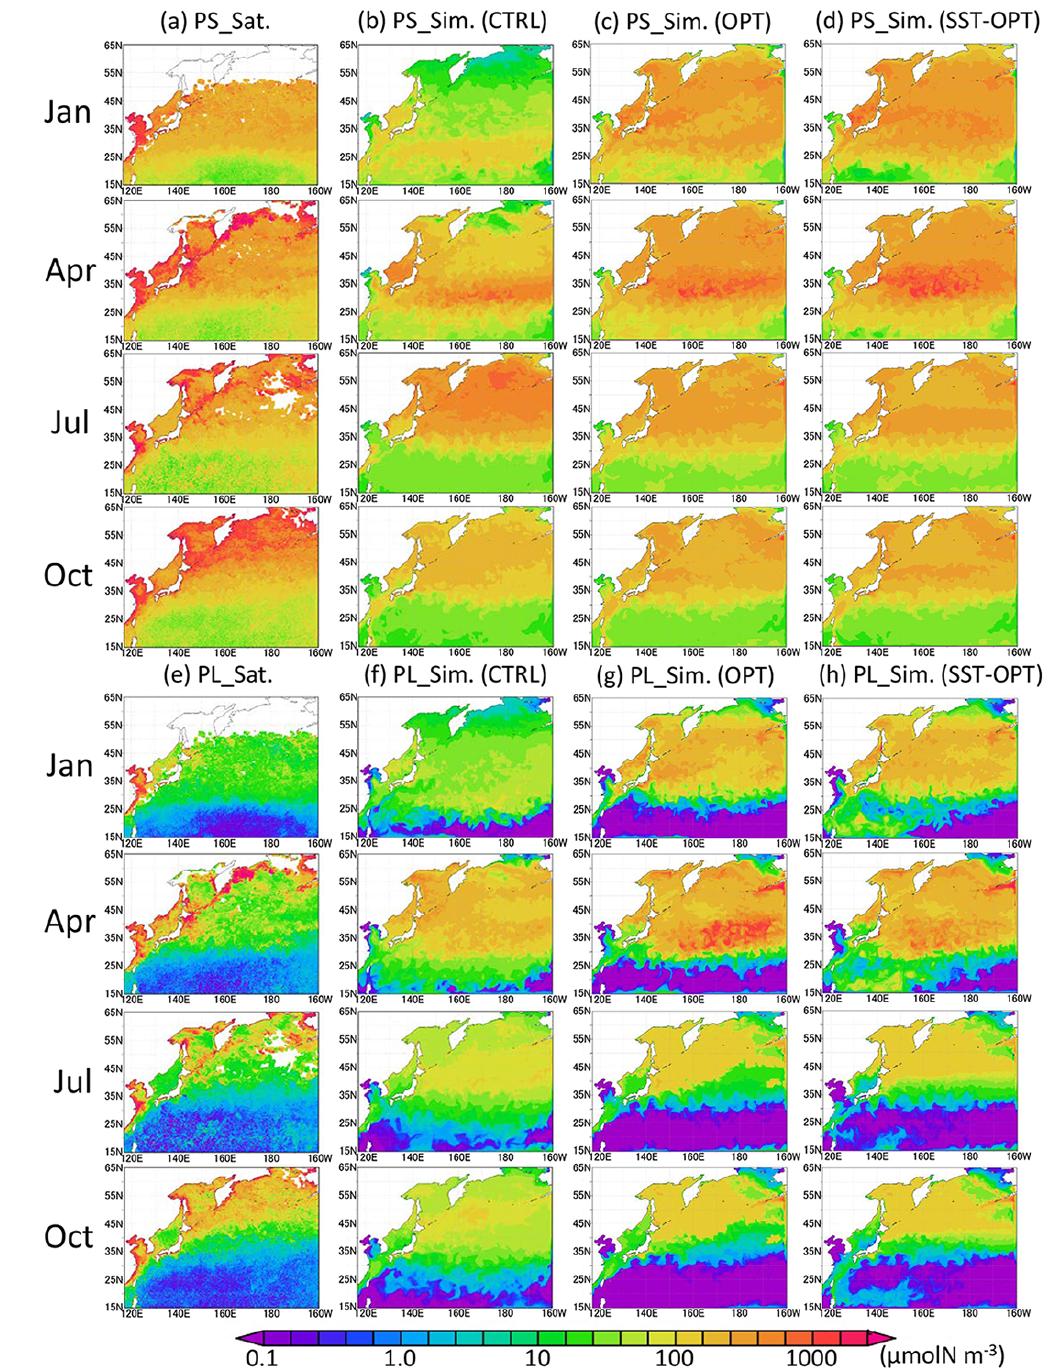
Figure 4. Horizontal distribution of phytoplankton at the surface in 1998. (a) PS (small phytoplankton) from satellite observations, (b) PS in the control case, (c) PS in the parameter-optimized case, and (d) PS in the SST-dependent case. Panels (e)–(h) are the same except for PL (large phytoplankton). Areas without satellite data are left